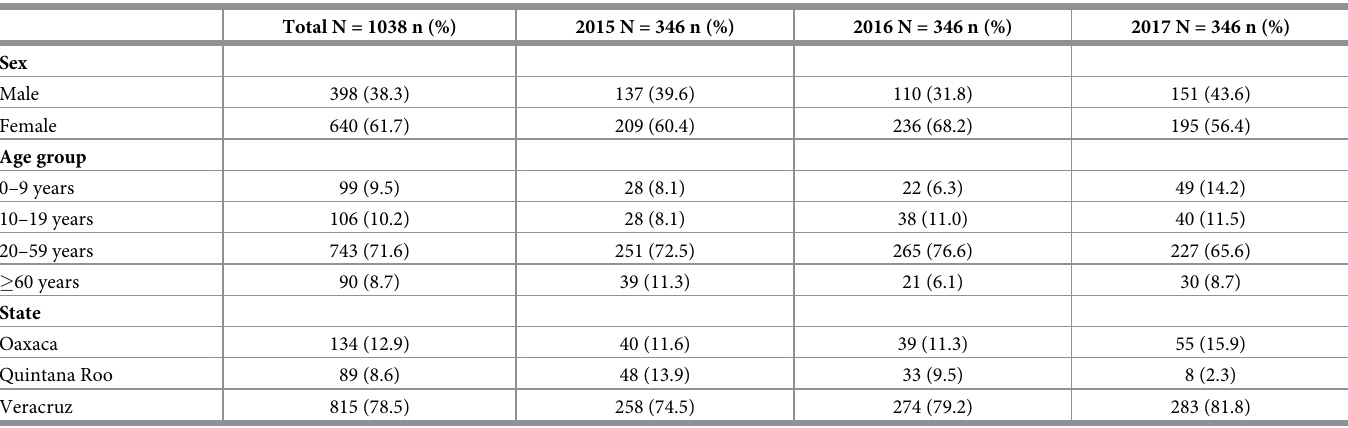
Table 2. Demographic data of the samples included in the study.